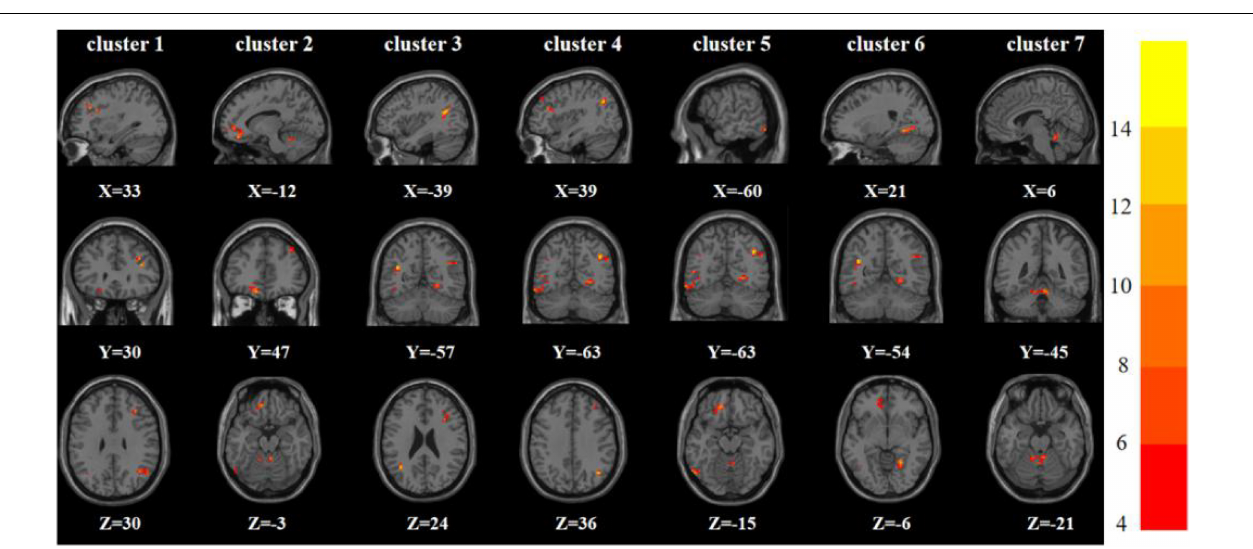
FIGURE 2 | Brain regions with abnormal ALFF among the three groups based on one-way analysis of variance. The color bars indicate the F